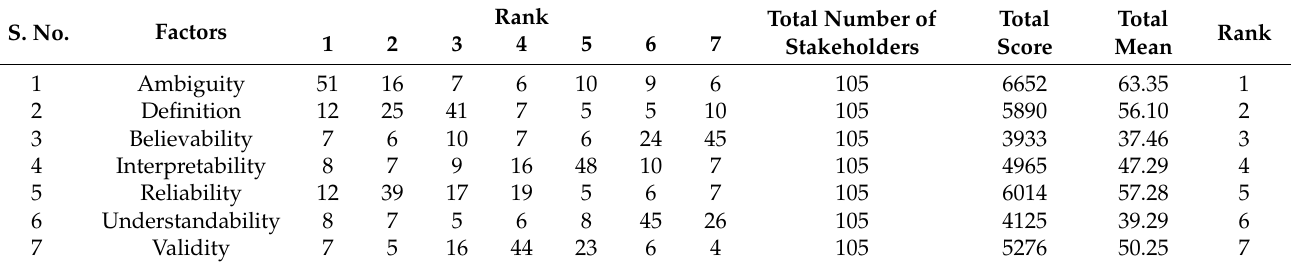
Table 9. Ranking of dimensions within the semantic category of the semiotic framework.